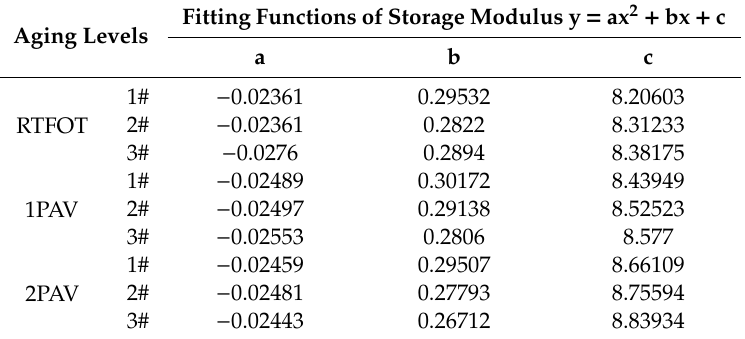
Table 4. Fitting parameters of master curves of storage modulus for the three aging levels. Aging Levels